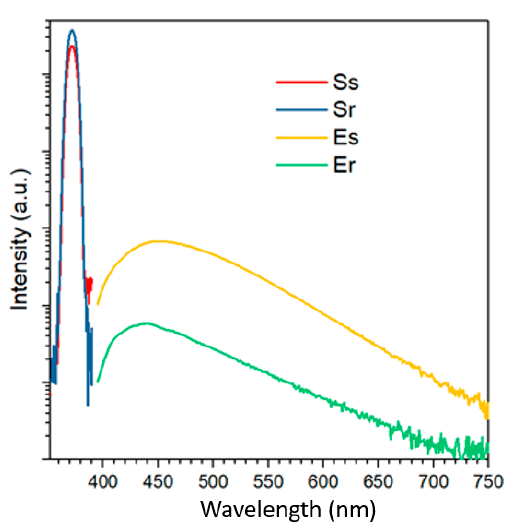
Figure 5. The PL spectra collected in the integration sphere.